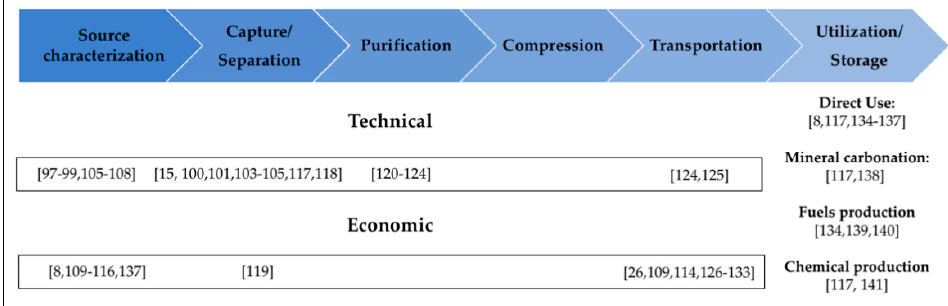
Figure 2. The six stages of a CCUS value chain.